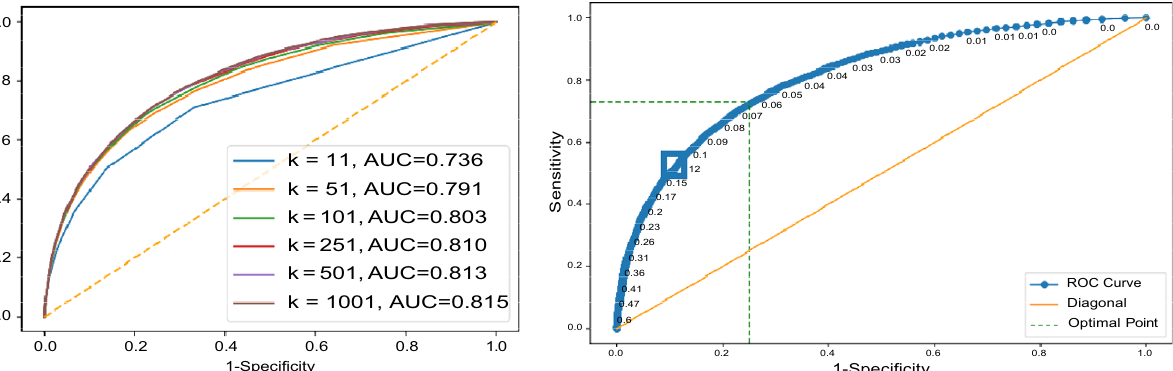
Figure 9. Analysis for Dataset 2. Left: Sample ROC curves for the proposed AutoThorax -Net for different k values in one fold and their area under the curve (AUC), Right: corresponding ROC thresholds for k = 1001 to select the sensitivity–specificity trade-off using Youden’s index.